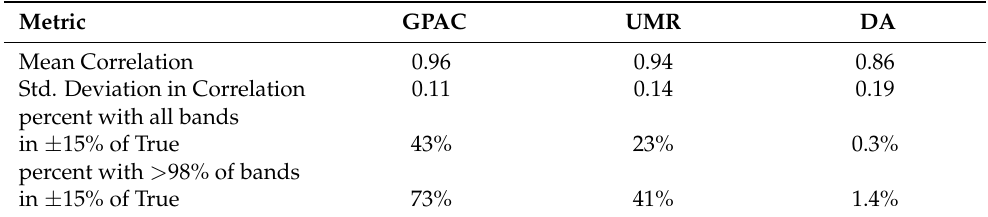
Table 1. Evaluation metrics for the Gaussian P Atmospheric Correction (GPAC), Universal Mean Regression (UMR), and Denoising Autoencoder (DA)